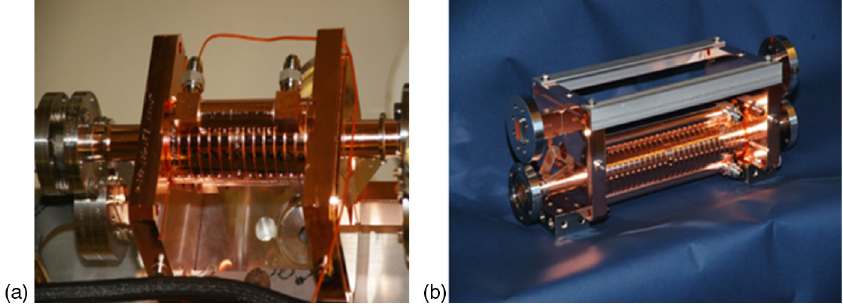
FIG. 14. X -band deflectors at SLAC ’ s NLCTA: (a) the 11-cell, and (b) 27-cell.